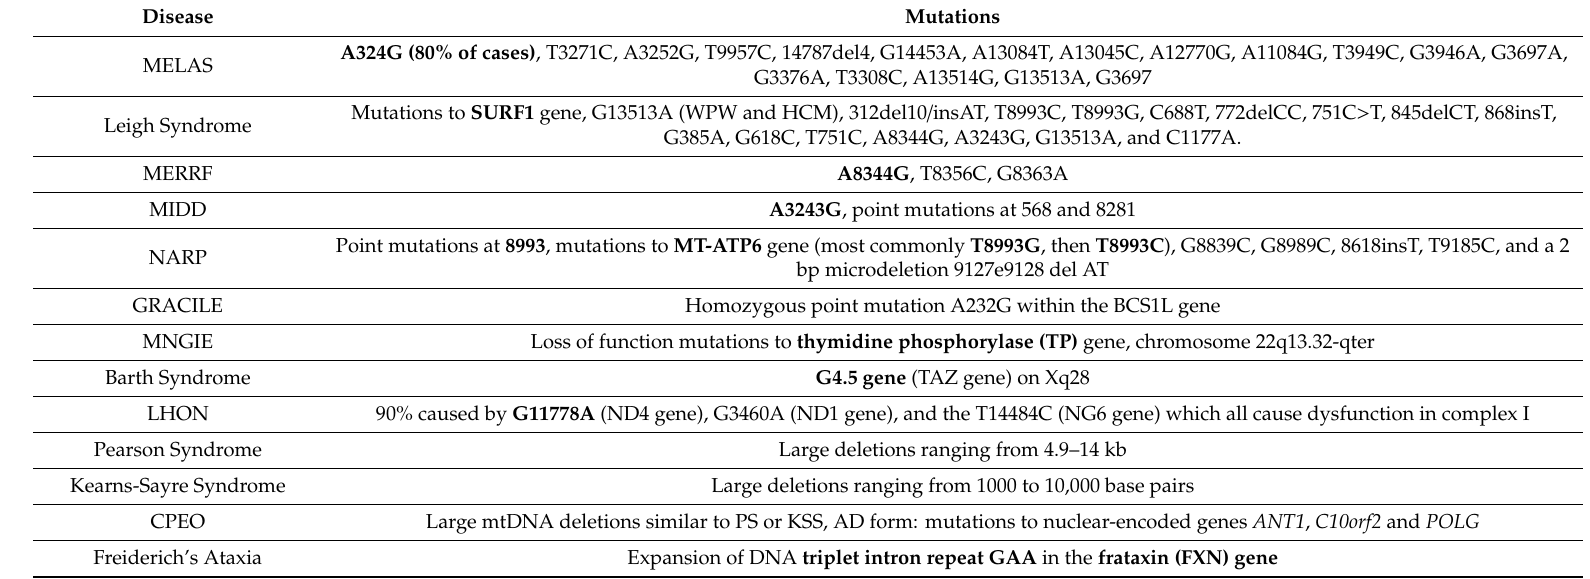
Table 2. Genetic mutations associated with mitochondrial